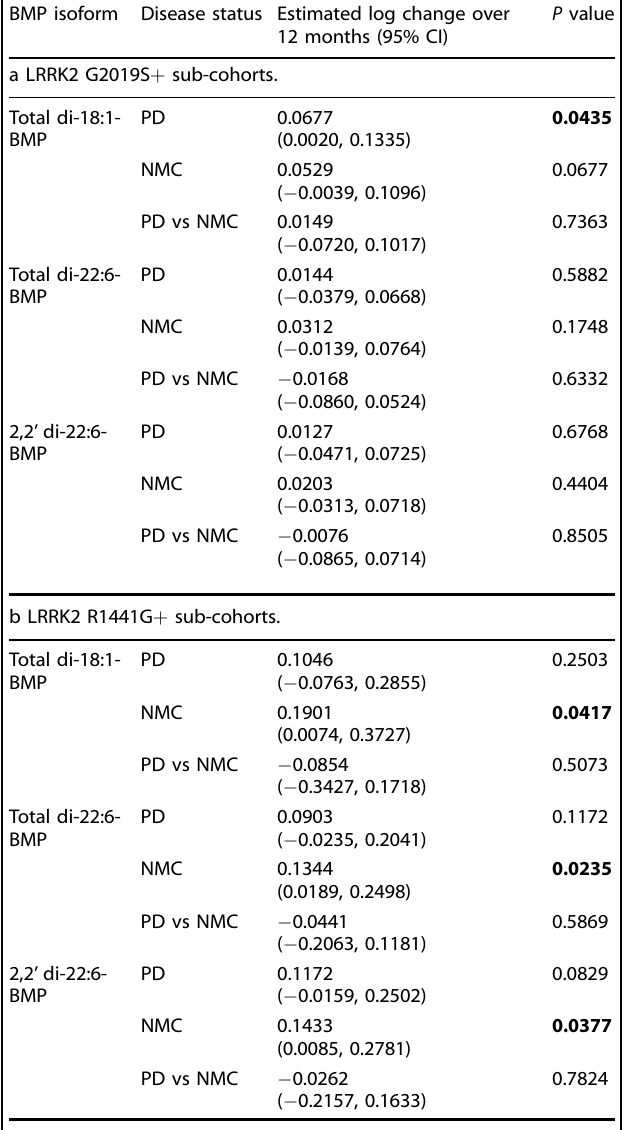
Table 2. Estimated annualized change in log BMP concentrations in LRRK2